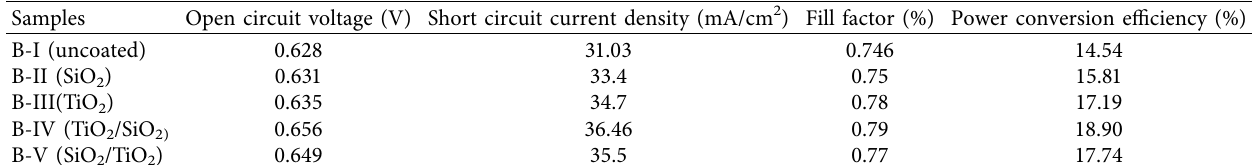
Table 3: Measured values of samples under direct sunlight.